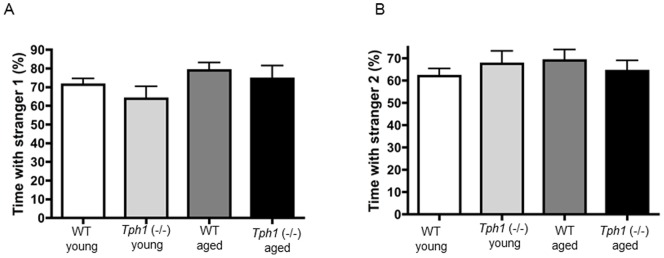

Tph1 (−/−) mice have a normal response to social novelty.
Tph1 (−/−) mice demonstrate similar responses to a stranger mouse (A) and to a novel mouse (B). The percentage of time that the test mouse spent exploring stranger 1 was comparable to age-matched WT animals (A) and the time that the test mouse spent exploring stranger 2 was comparable to age-matched WT mice (B).